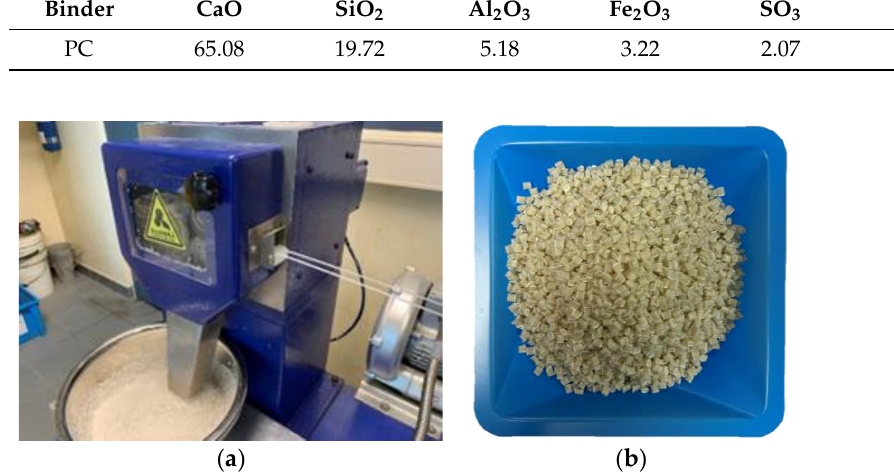
Figure 1. Production of MPFA: ( a ) Pelletizer unit of the twin-screw extruder and ( b ) MPFA Table 1. Chemical composition of PC